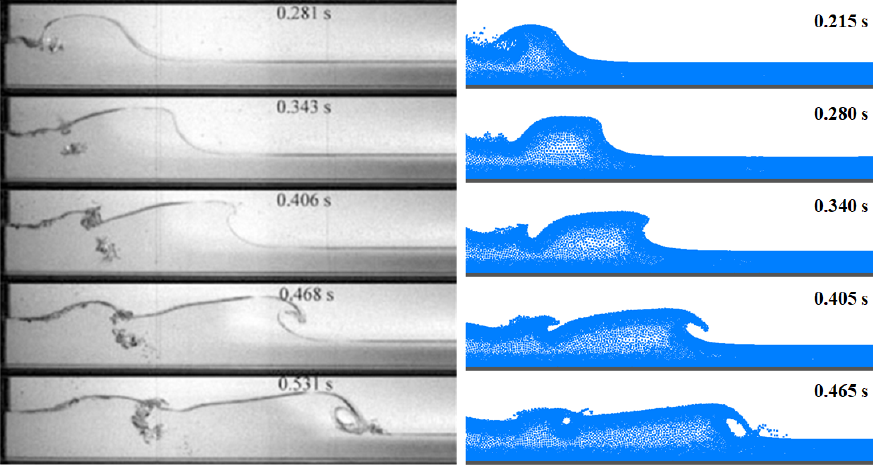
Figure 25. Dam-breaking flows simulated via a single-phase SPH model with ASR